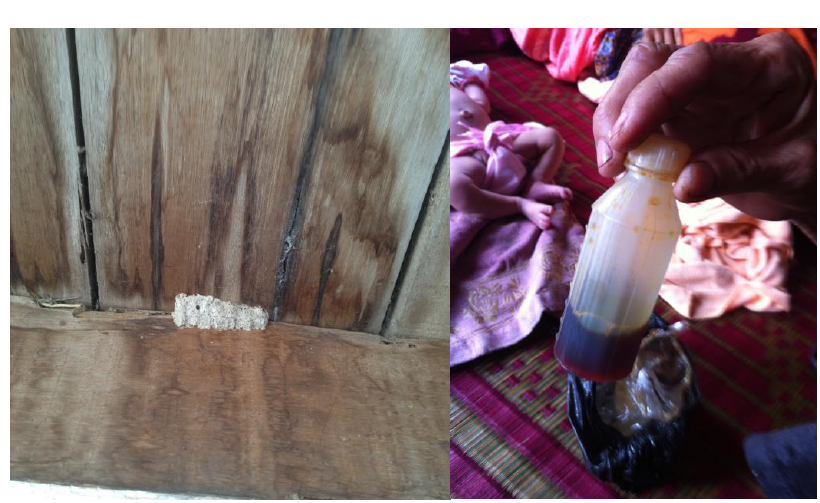
Figure 4. Substances applied to the umbilical cord.